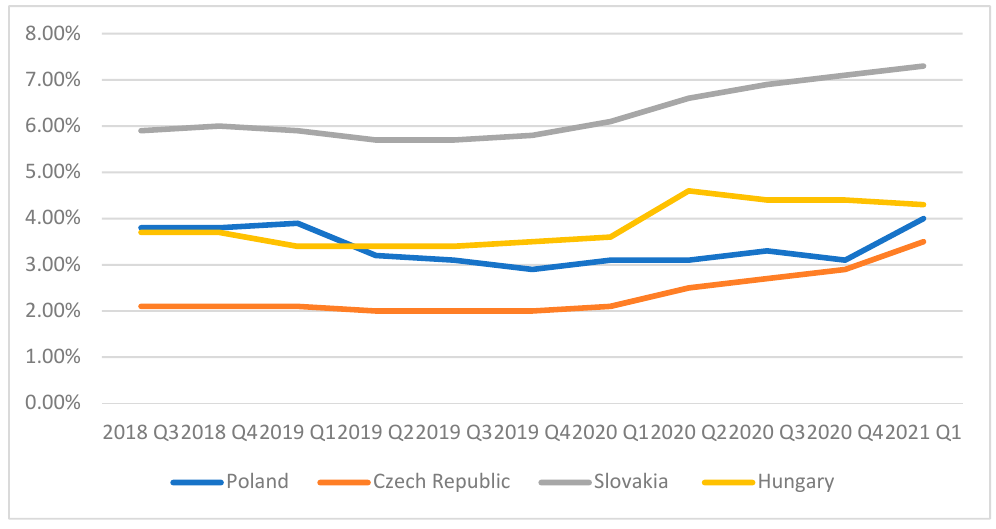
Figure 1. Unemployment rate in selected CEE countries. Source: (Eurostat Database 2021).